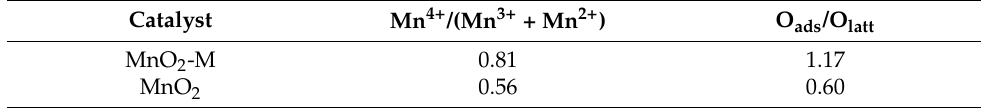
Figure 5. XPS spectra: Mn 2p ( a ) and O 1s ( b ) of the catalysts. Table 3. Surface compositions of the catalysts by XPS analysis.